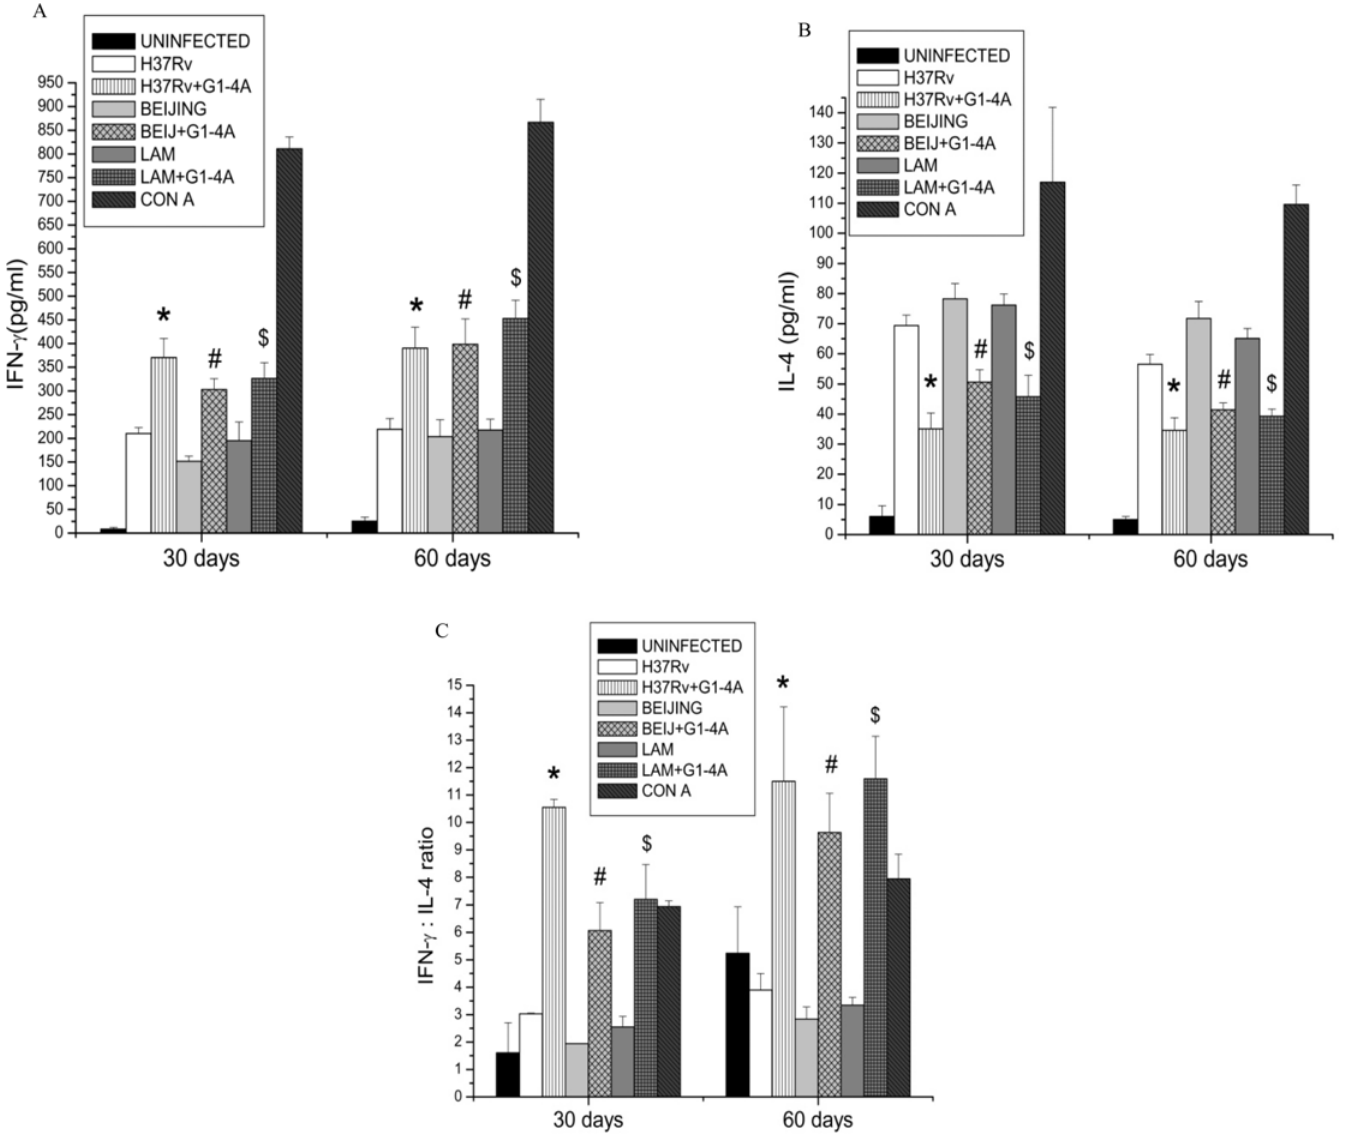
Fig 9. G1-4A enhances IFN- γ and IL-4 ratio in MTB infected mice. Splenocytes isolated from BALB/c after 30 and 60 days of infection either in presence or absence of G1-4A, were treated with PPD and conA for 72 h. Levels of IFN- γ and IL-4 were determined in supernatant. (A) IFN- γ (B) IL-4 (C) IFN- γ /IL-4 ratio. Results shown here are representative of at least three independent experiments performed and presented as mean ±